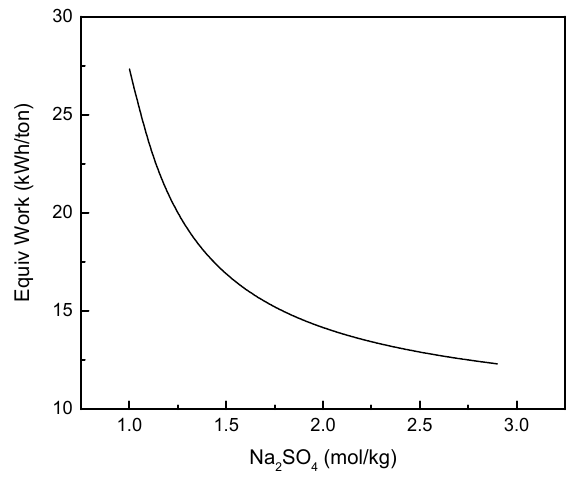
Figure 16. Equivalent work of the FO process using Na 2 SO 4 as the draw solute.